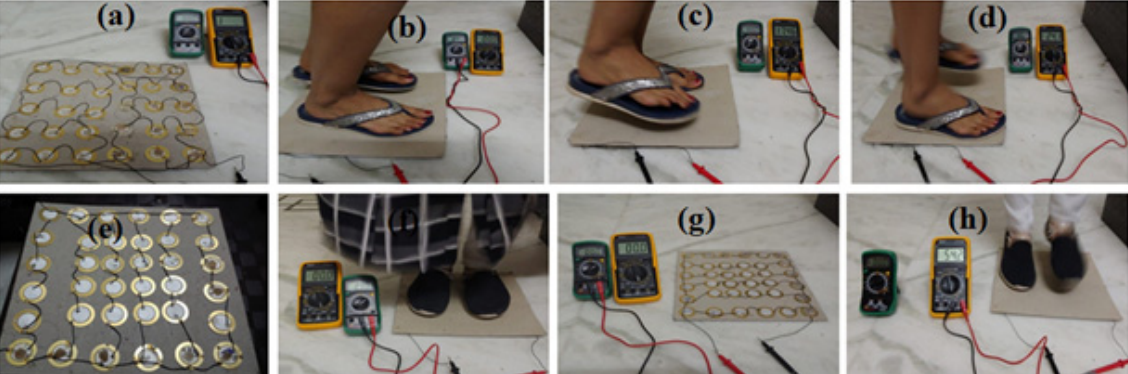
Figure 5. ( a ) Connection of 6 × 6 PZT sensors in series-parallel (S-P) configurations, ( b ) applied force of 65 kg with varying foot position 1, ( c ) applied force of 65 kg with jumping mode 1, ( d ) applied force of 65 kg with jumping mode 2, ( e ) connection of 6 × 6 PZT sensors in S-P configurations via changing alignment of sensors (CAS), ( f ) applied force of 65 kg with jumping mode position 1 via CAS, ( g ) connection of 6 × 6 PZT sensors in S-P configurations via CAS and connection and fixation of sensors via CAS, and ( h ) applied force of 65 kg with jumping mode position 2 via CAS.